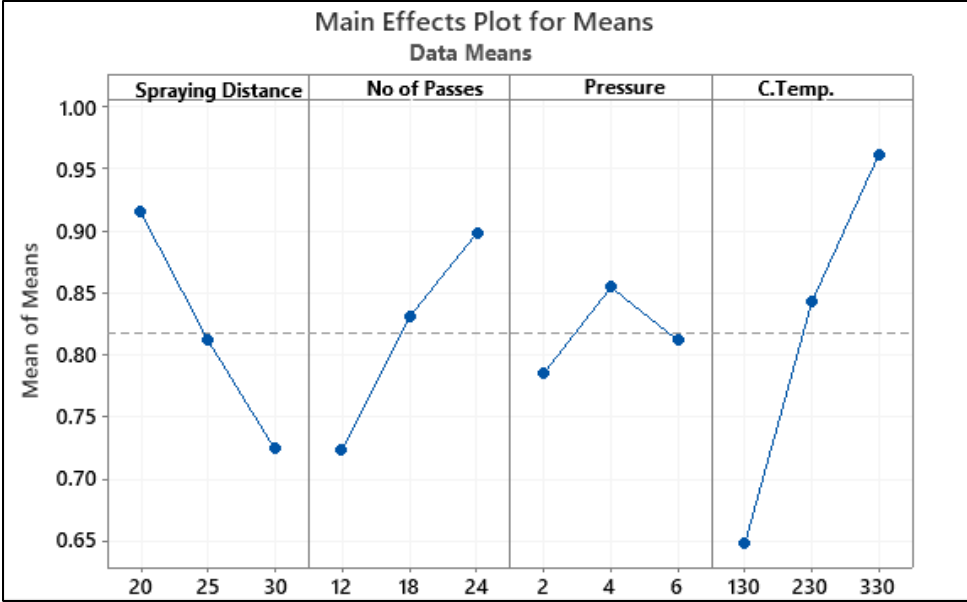
Figure 2. Effect of coating parameters on C d .